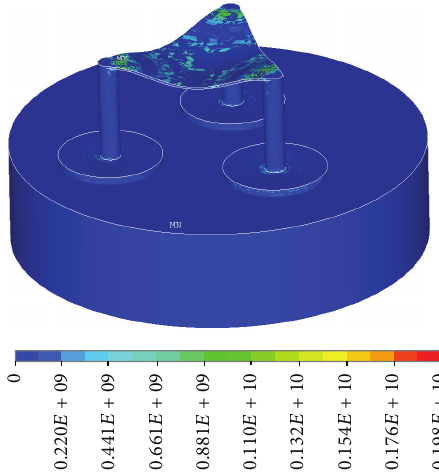
Figure 11: Stress intensity (Nodal